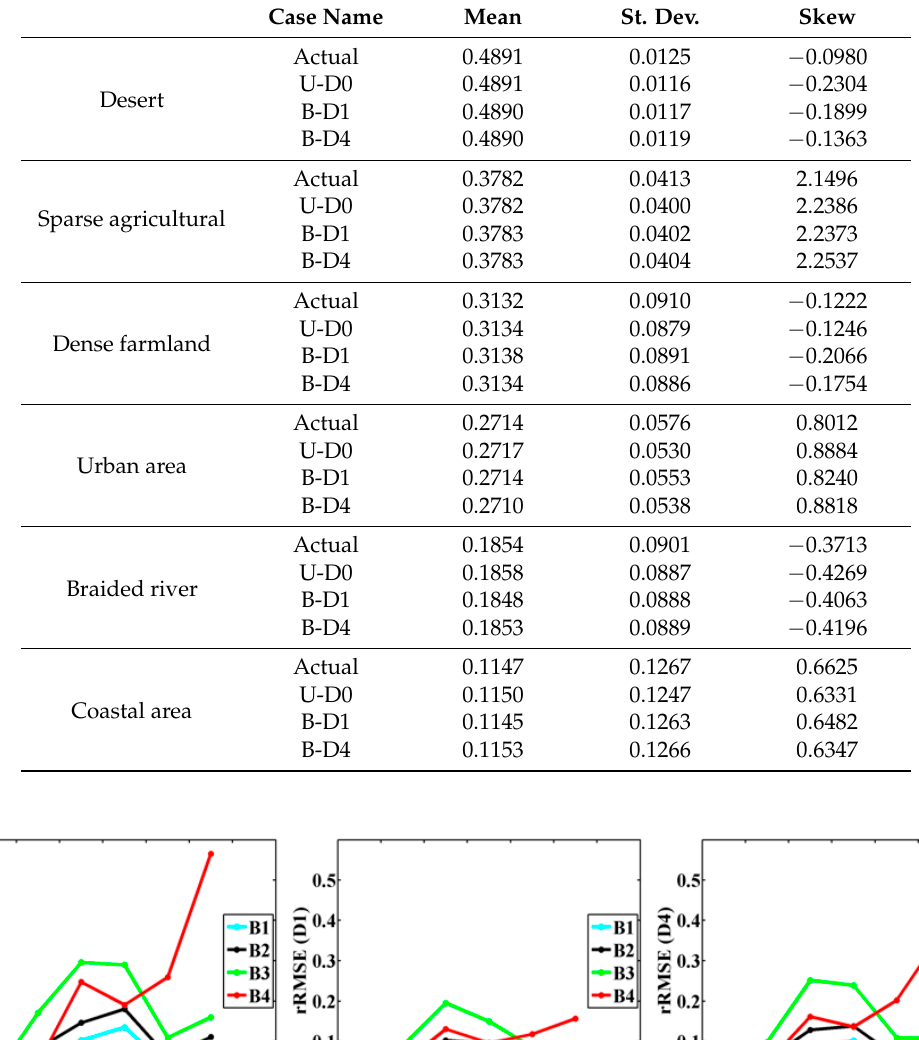
Table 5. Summary statistics of band 4 for the target images and filled results of six studied regions.